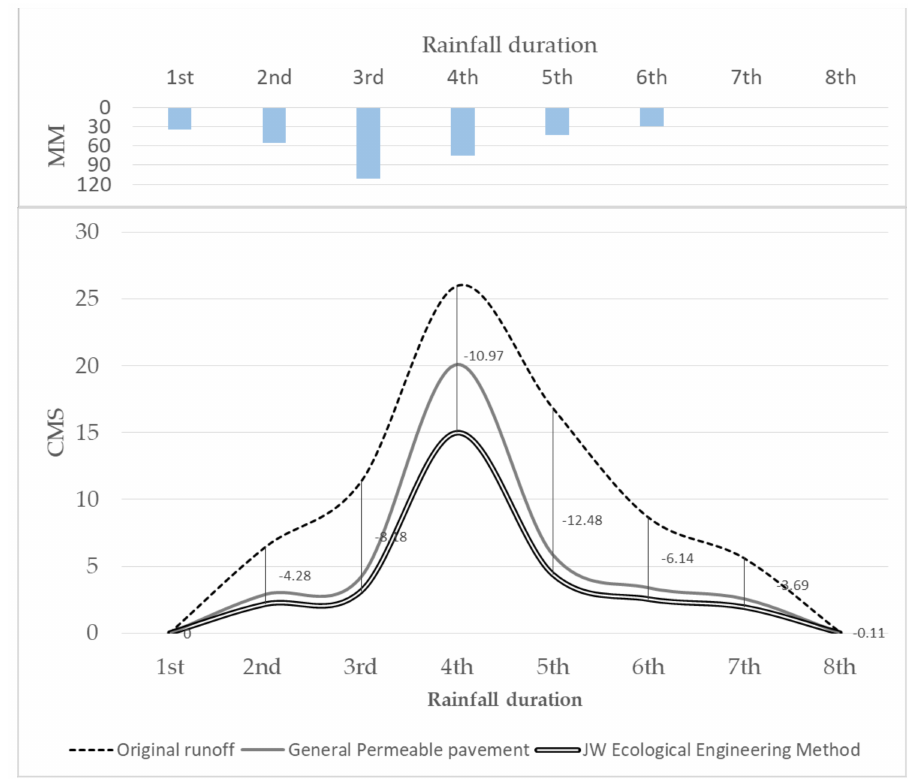
Figure 7. Simulation result for 6 h/350